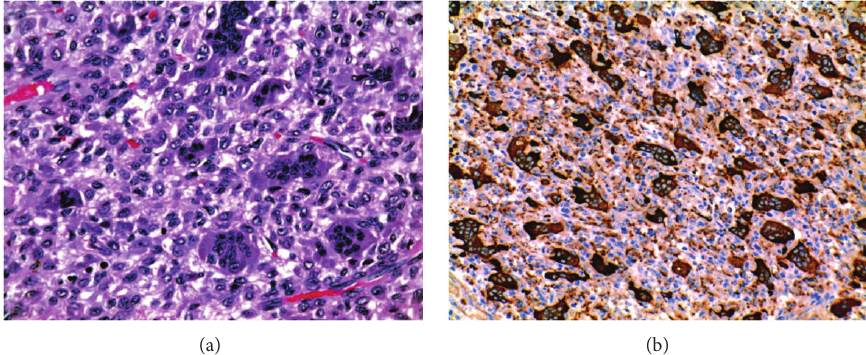
Figure14:(a)Hematoxylin-eosinstainedtissuedemonstratedahighlycellular,solidneoplasmconsistingofmononuclearcellsandosteoclast- like giant cells; (b) intense immunohistochemical staining for CD68 (KP1).